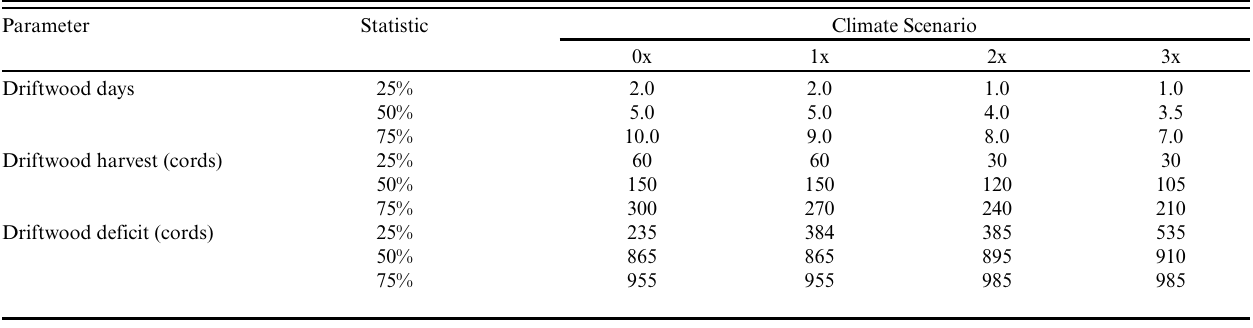
Table 4 . Climate variability scenarios: parameter definition and results summary.